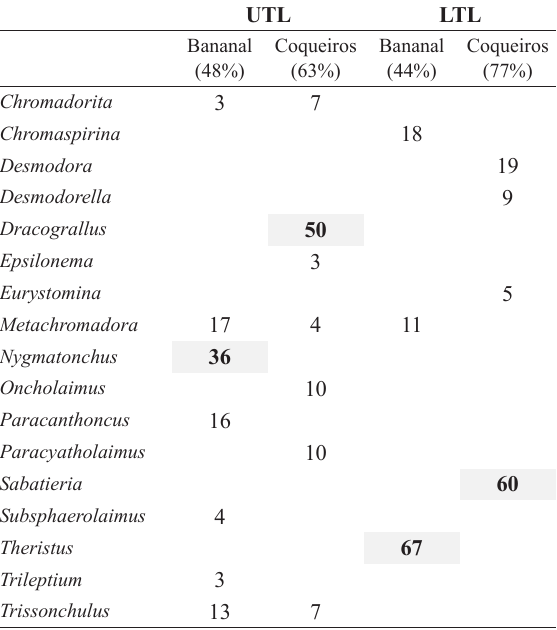
Overall similarity for each beach level is given in